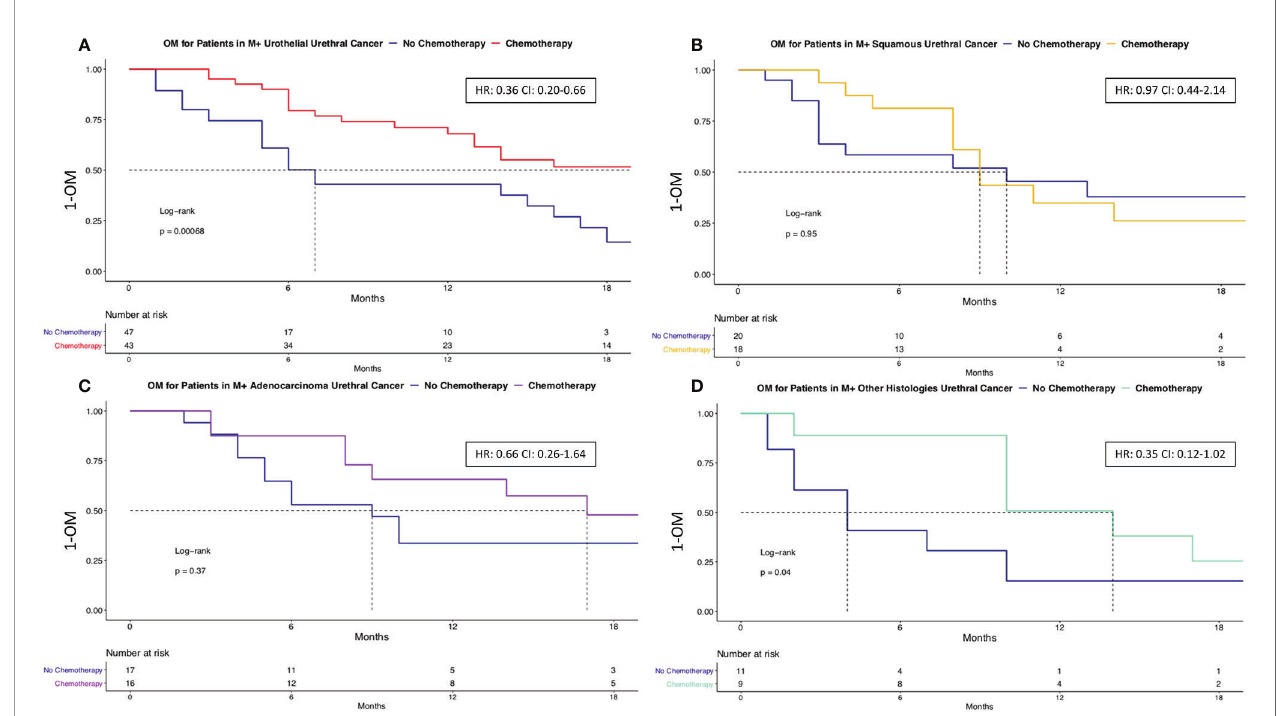
FIGURE 5 | Overall mortality of chemotherapy vs. no chemotherapy in variant histologies of metastatic urethral cancer. Kaplan-Meier plots illustrating overall mortality (OM) in metastatic urethral cancer patients for urothelial and variant histology. Panel (A) depicted the comparison between chemotherapy and no chemotherapy in urothelial histological subtype. Panel (B) depicted the comparison between chemotherapy and no chemotherapy in squamous cell carcinoma histological subtype. Panel (C) depicted the comparison between chemotherapy and no chemotherapy in adenocarcinoma histological subtype. Panel (D) depicted the comparison between chemotherapy and no chemotherapy in other histological subtypes. OM, Overall mortality; HR, Hazard ratio; CI, Con fi dence interval; Squamous, Squamous cell